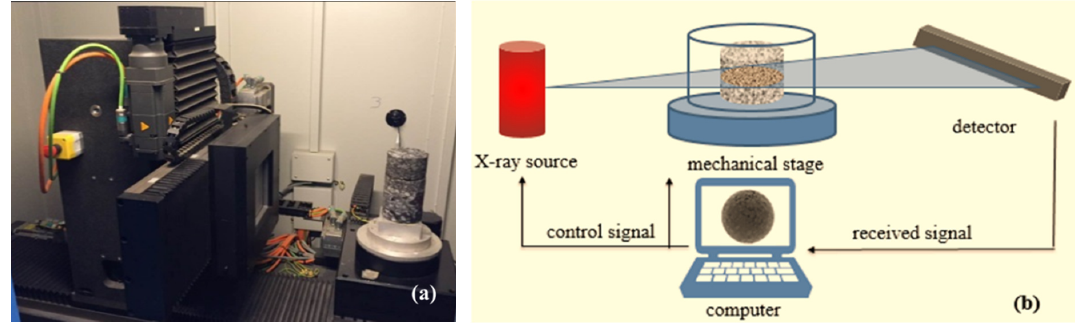
Figure 3. The basic principle and equipment for a computed tomography (CT) scanning test. Table 2. Basic parameters of the computed tomography (CT) technique.